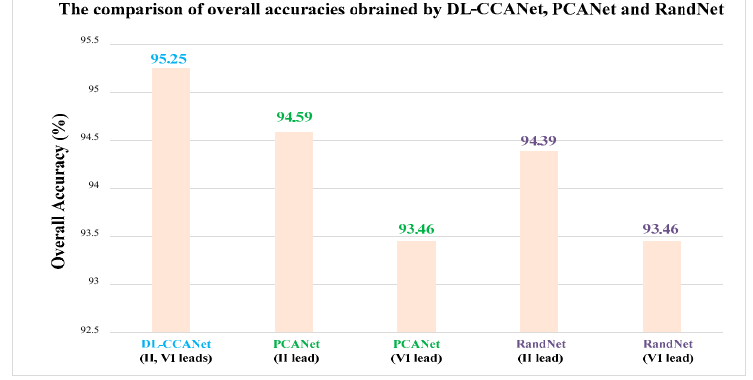
Figure 4. The comparison of DL-CCANet, PCANet, and RandNet on the MIT-BIH database.